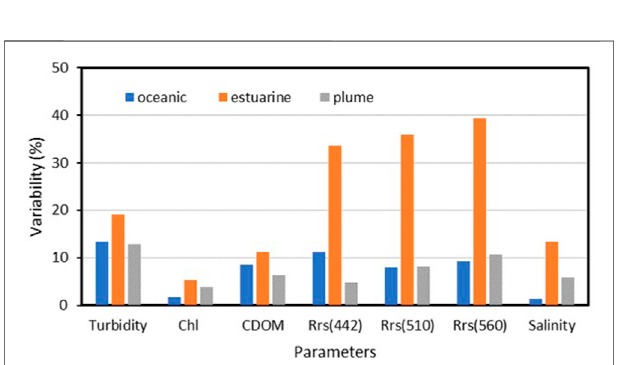
FIGURE 10 | Variability (CV) analysis of R rs (0+) at Band 3 (442.5 nm), Band 5 (510 nm) and Band 6 (560 nm), Turbidity, Chlorophyll, CDOM, and salinity parameters for oceanic, estuarine, and plume waters on 2 September 2019 SoG waters. The analysis shown at 300 m high resolution PGR.